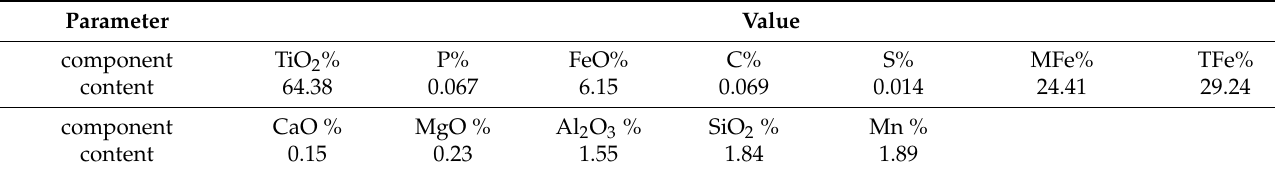
Table 5. Position of monitoring section and monitoring line. Table 6. Results of corrosion